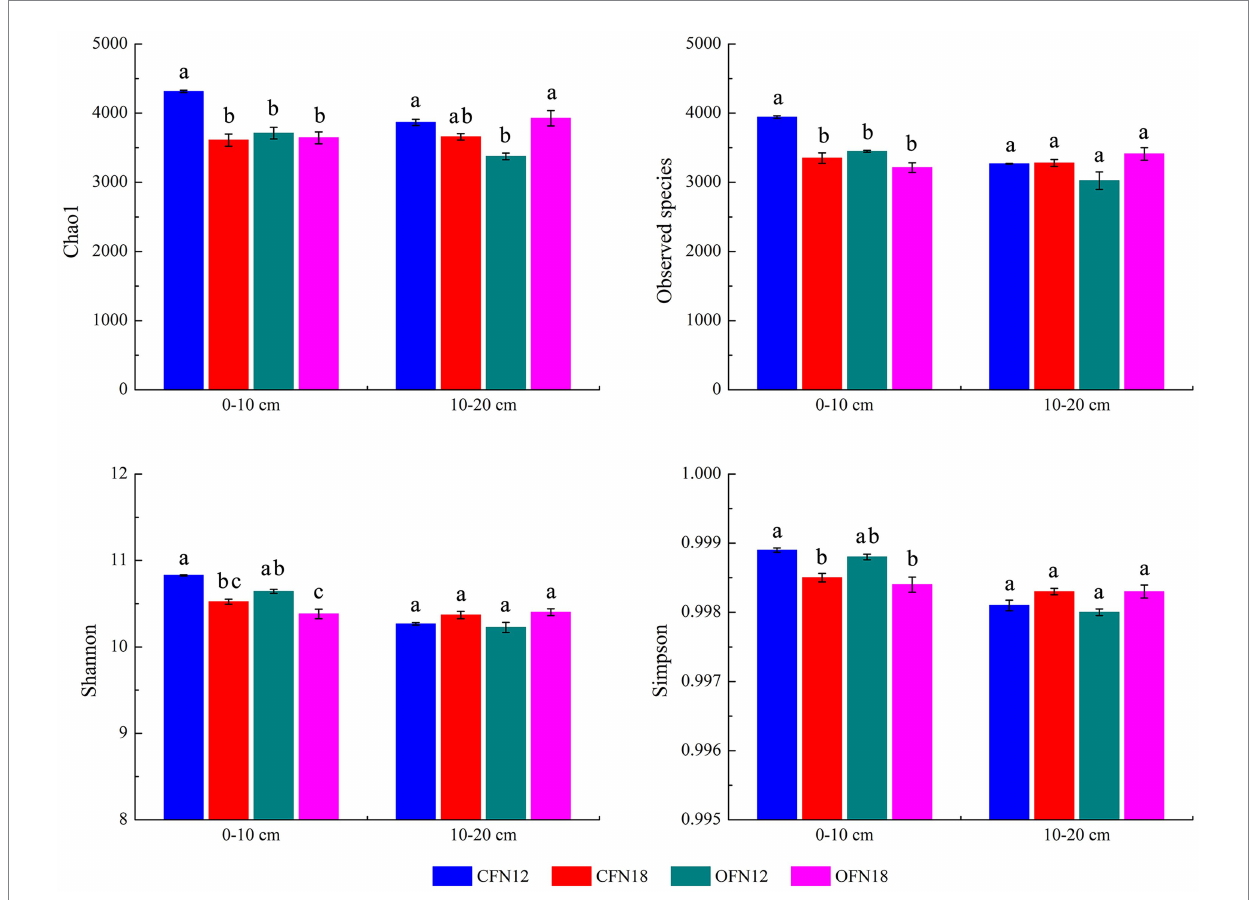
FIGURE 3 Alpha diversity of bacteria under two nitrogen levels of conventional and organic cultivation. Different lower case letters indicate significant differences among the four treatments at p <